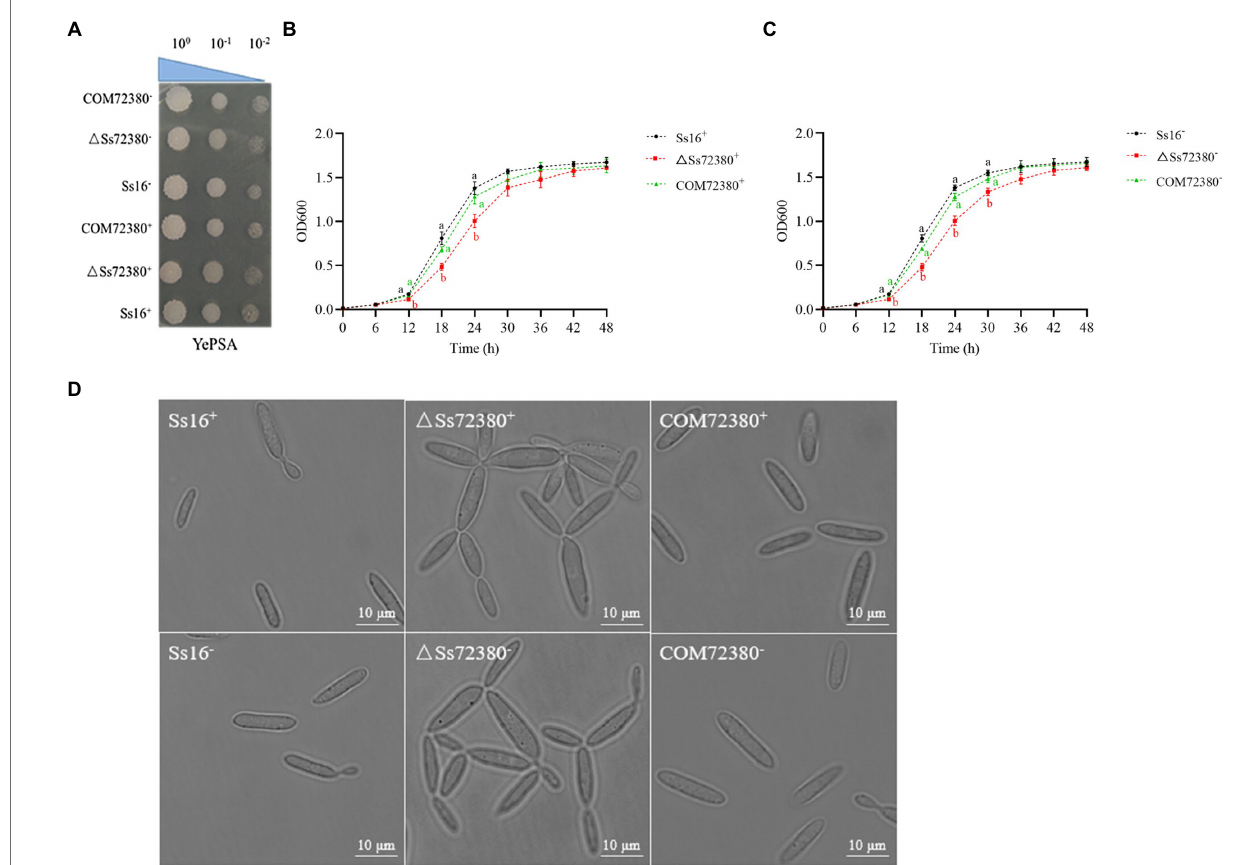
FIGURE 3 | Effects of the SsCI72380 gene on the haploid phenotype of S. scitamineum . (A) Haploid colonies of wild-types ( Ss16 + and Ss16 − ), knockout mutants ( Δ Ss72380 + and Δ Ss72380 − ), and complementary mutants ( COM72380 + and COM72380 − ) were spotted on YePSA plates and incubated at 28 ° C for 48 h. (B,C) Haploid growth curve, each sample had three replicates. Bars indicate the SE. Different lowercase letters represent a difference at the 0.05 level. (D) Microscopic images of sporidia of WT, deletion mutants, and complementary mutants (YePS liquid medium, 28 ° C, 200 rpm, 48 h, observed under 100× oil immersion